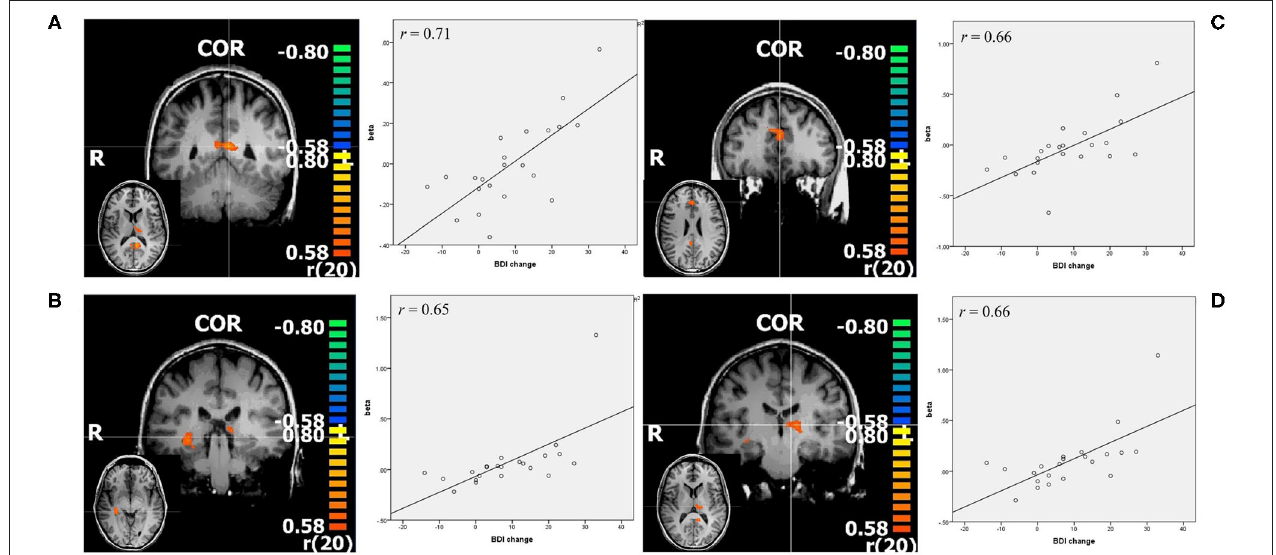
FIGURE 3 | Resulting regions of correlation analysis with change in BDI in contrast negative > neutral. The color bars represent r values, p < 0.005. (A) PCC: posterior cingulate cortex; (B) right hippocampus; (C) ACC; pregenual anterior cingulate cortex; (D) left thalamus, all shown in coronal slice, with transverse slice shown in small. Additionally scatterplots of the depicted regions beta values and change in BDI are shown, as well as r = Pearson’s correlation